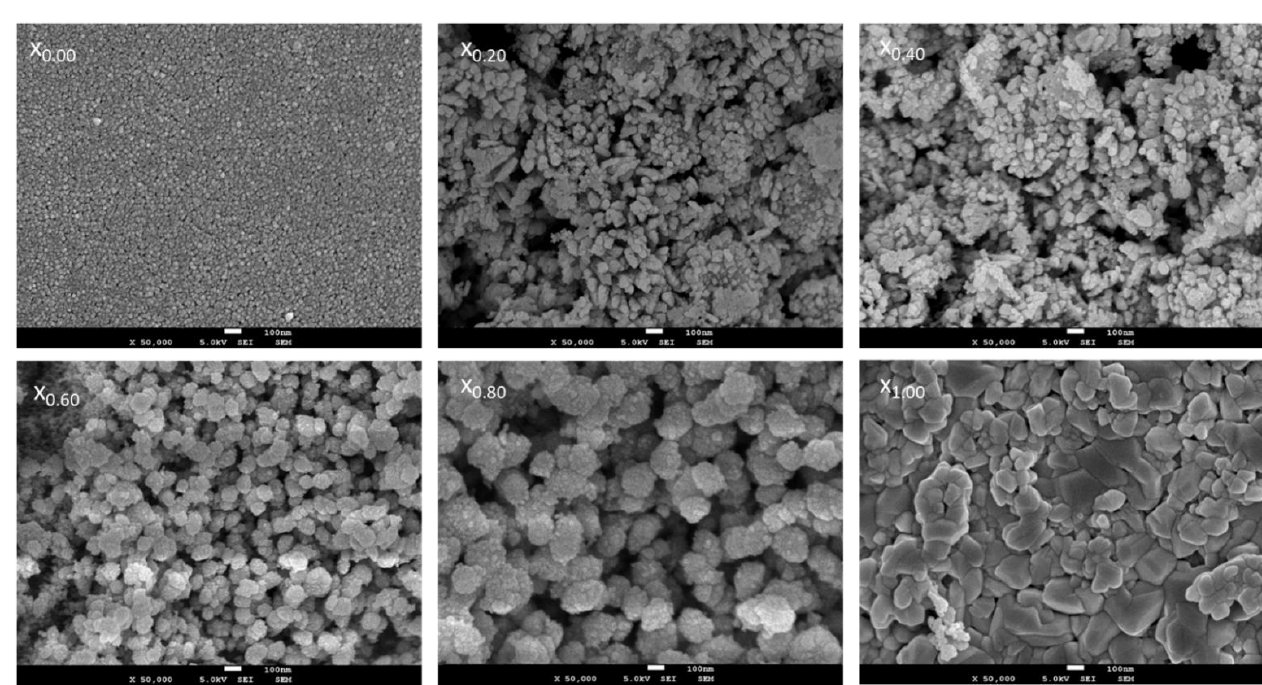
Figure 5. SEM images of (x 0.00 ) Ce 0.00 Sn 1.00 O 2 , (x 0.20 ) Ce 0.20 Sn 0.80 O 2 , (x 0.40 ) Ce 0.40 Sn 0.60 O 2 , (x 0.06 ) Ce 0.60 Sn 0.40 O 2 , (x 0.08 ) Ce 0.80 Sn 0.20 O 2 and (x 1.00 ), Ce 1.00 Sn 0.00 O 2 ) nanoparticles calcined at 650 °C.